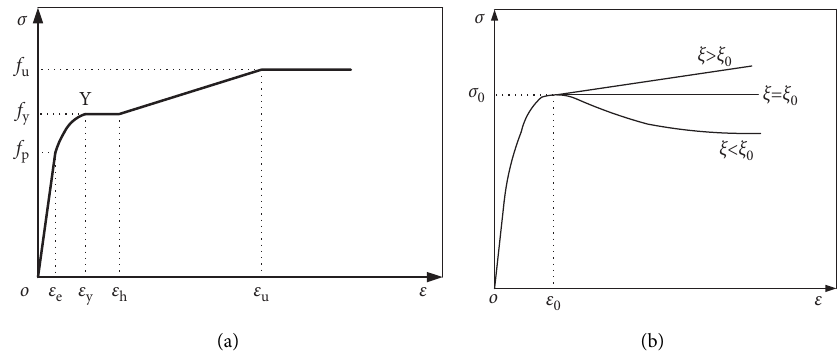
Figure 1: Stress-strain relation model. (a) Steel. (b)